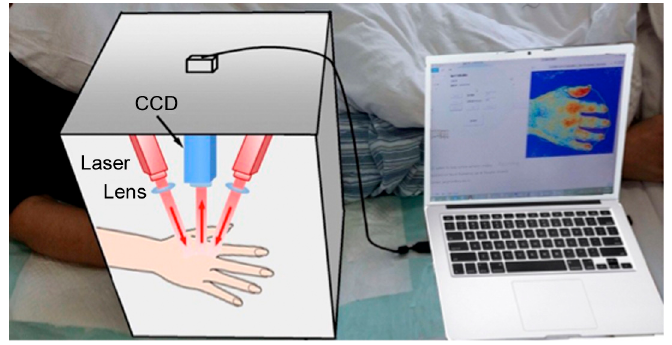
Figure 1. Portable imaging box developed for the imaging data acquisition.